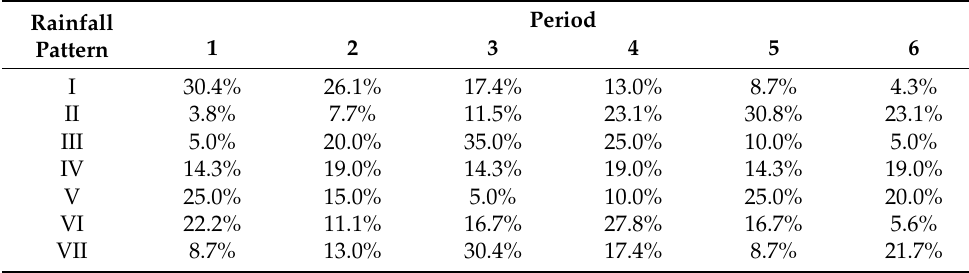
Table 1. Pattern matrix of the seven rainfall